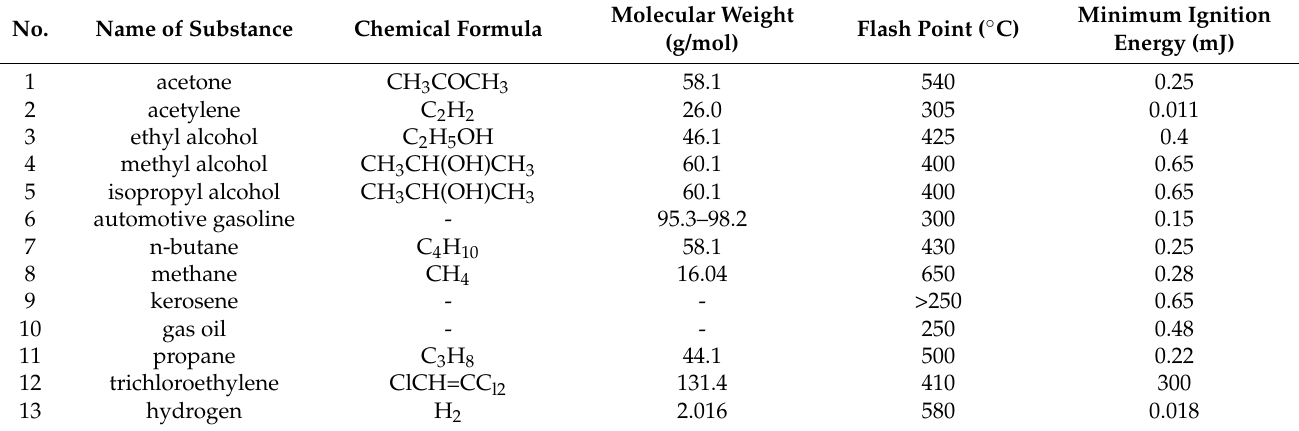
Table 4. Flash points and minimum ignition energies for the selected flammable gases and vapours of